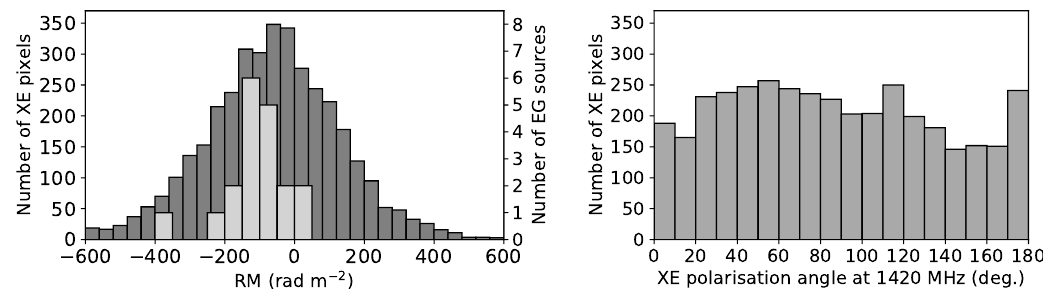
Figure 2. Left: The distribution of XE RM pixels after the filtering process (dark gray) and EG RM sources (light gray) within one 1.5 ◦ wide longitude bin, centred at (cid:96) = 137.5 ◦ . Right: The distribution of XE polarisation angles measured at 1420 MHz within the same longitude bin. While the XE polarisation angles seem to be randomly distributed within the bin, the XE RM values have a clear peak.